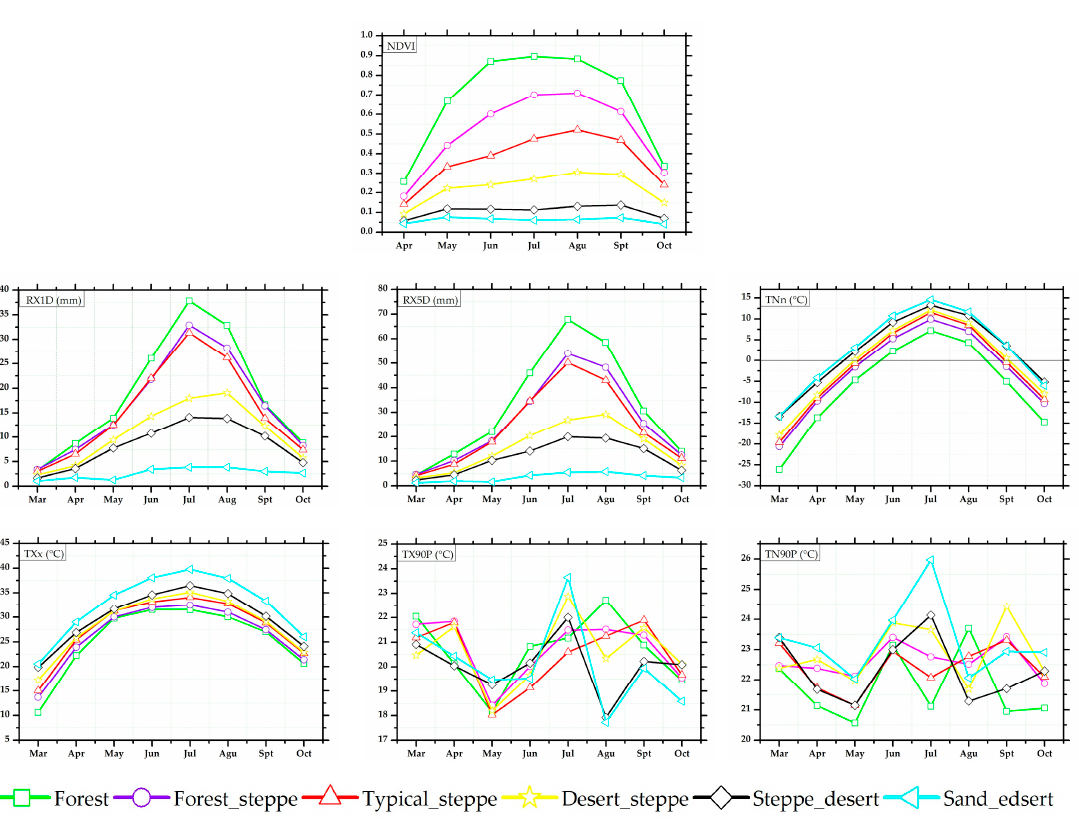
Figure 5. Trends of mean monthly NDVI and extreme climate indices of growing seasons in different vegetation types during 1982–2015.